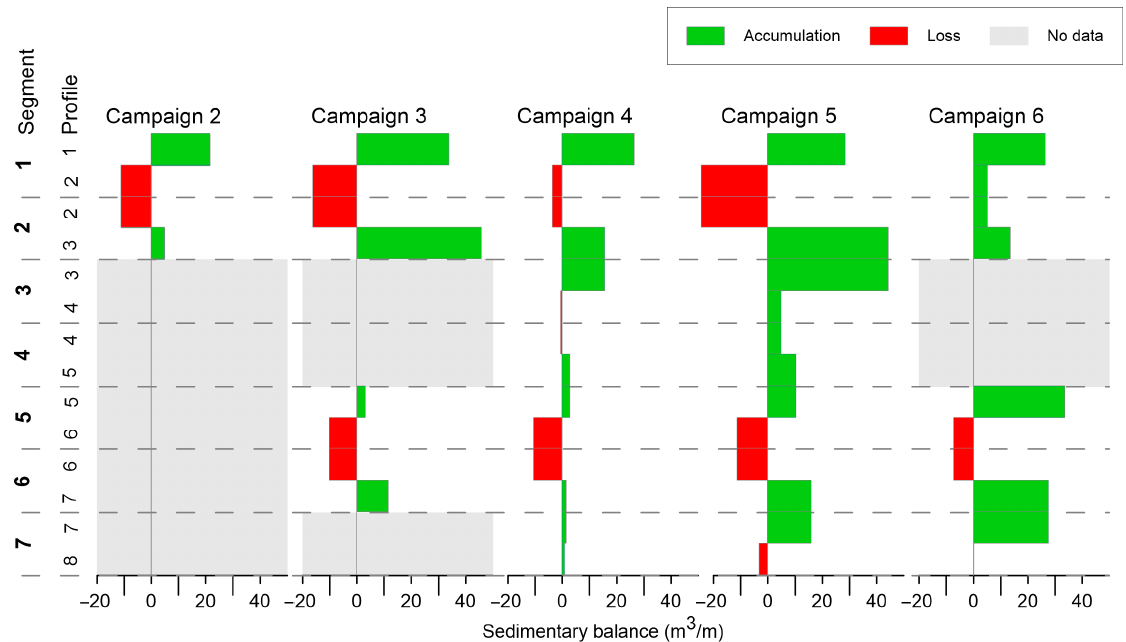
Figure 4. Sedimentary balances for each segment. The balances are shown as the accumulation (+) in green, and losses ( − ) in red, between each of the campaigns.